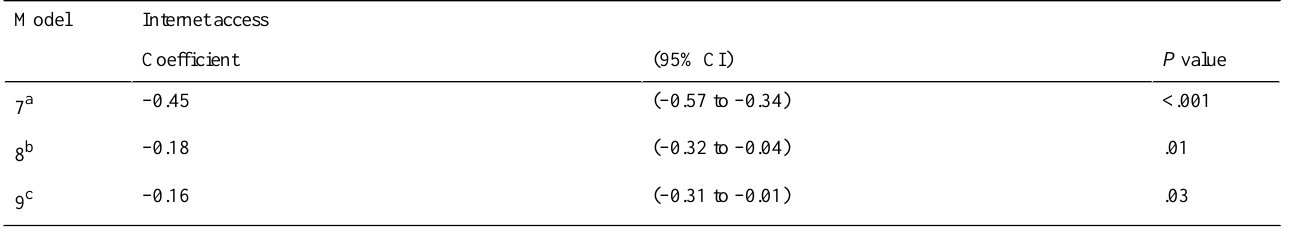
Table 7. Results of analyzing the influence of “accessing the internet” on medical choice behaviors (self-care versus hospital care, ref=self-care). Internet accessModel